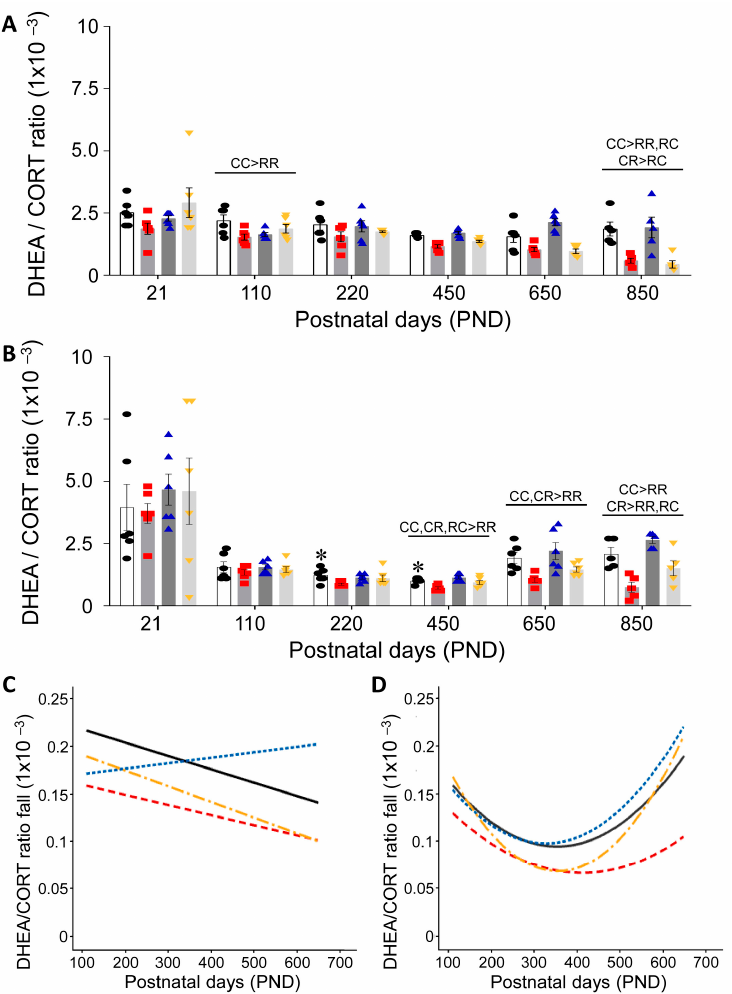
Figure 4. Serum DHEA:CORT ratios are presented in ( A ) male and ( B ) female: CC (open histograms, black circles), RR (grey histogram, red squares), CR (grey histogram, blue triangles) and RC (light-grey histogram, yellow inverted triangles) at six life course stages. Data are mean ± SEM, group n = 6 at all ages except PND 850 where n = 5. Differences between the groups of the same sex are indicated on the lines above each age ( p < 0.05). * p < 0.05 male vs. female in C groups at the same age. ( C ) male and ( D ) female show best-fit curves for the DHEA:CORT ratio fall in each group: CC solid black, RR red dash, CR blue dash and RC yellow dash line.